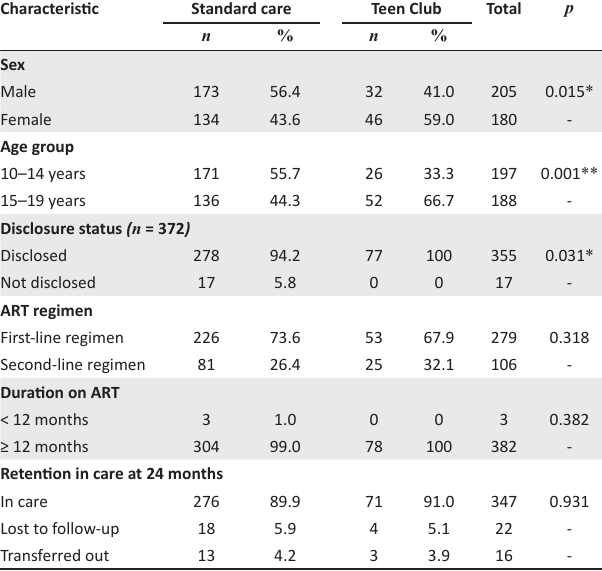
TABLE 2: The demographic and clinical characteristics of adolescent participants on antiretroviral therapy at the Intermediate Hospital Katutura Paediatric Antiretroviral Therapy Clinic ( N = 385). Characteristic